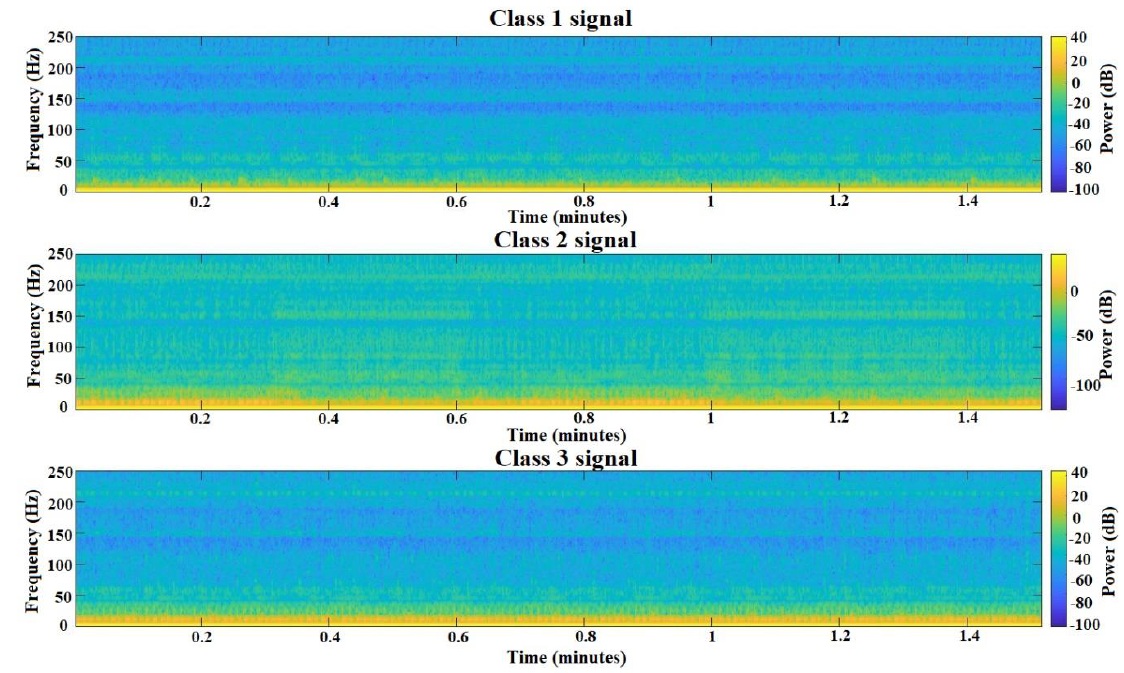
Figure 10. Spectrograms of each of the signal classes.